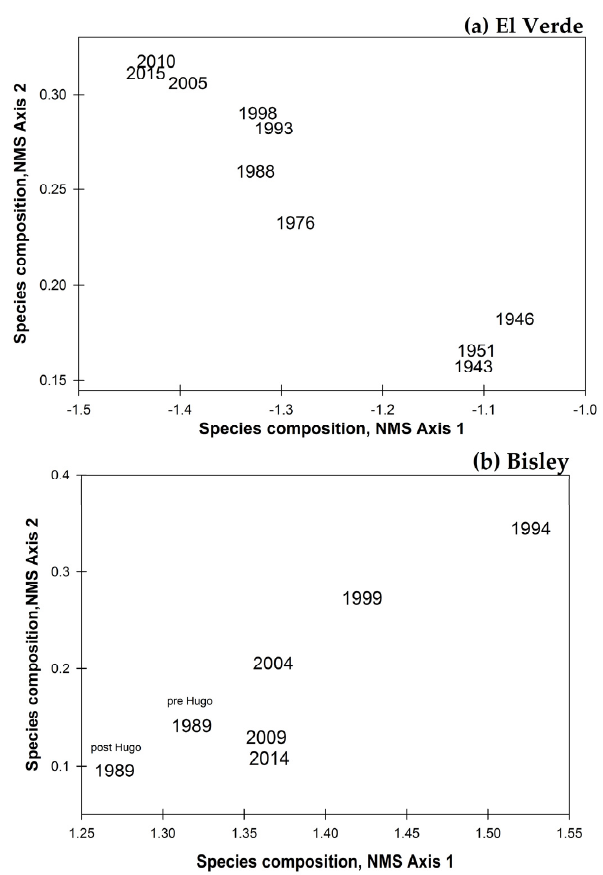
Figure 8. Non ‐ metric multidimensional scaling (NMS) ordination based on species composition and abundance per census of two tabonuco forest permanent plot sites at Luquillo Experimental Forest, Puerto Rico. Top panel ( a ) El Verde and bottom panel ( b ) Bisley.